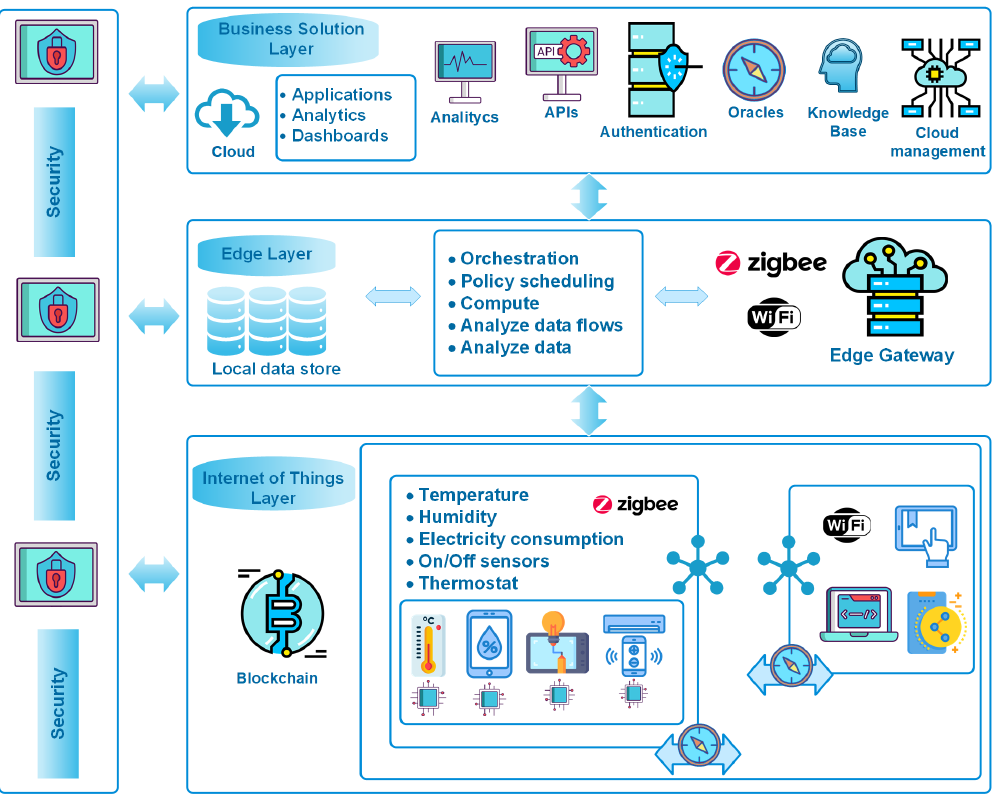
Figure 4. Applying the Global Edge Computing Architecture to Energy Efficiency